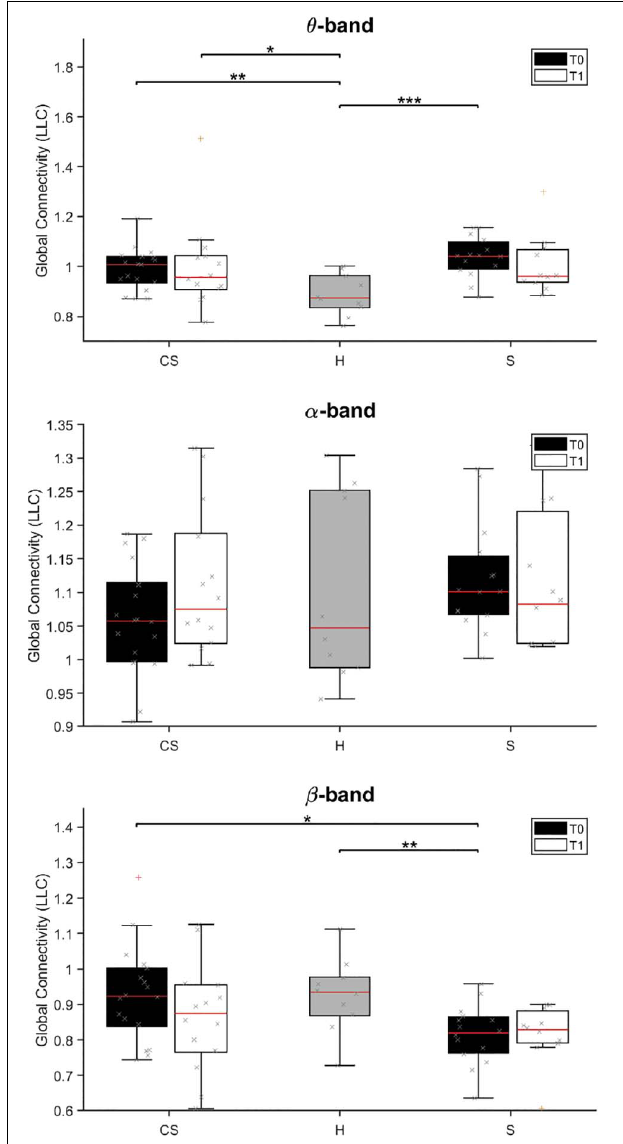
FIGURE 5 | Lagged Linear Connectivity (LLC) values in θ -band (top panel), α -band (middle panel) and β -band (bottom panel) at T0 and T1 for cortico-subcortical (CS) and subcortical (S) patients, compared with LLC values in the group of healthy subjects (H). * p < 0.05, ** p < 0.01, *** p <